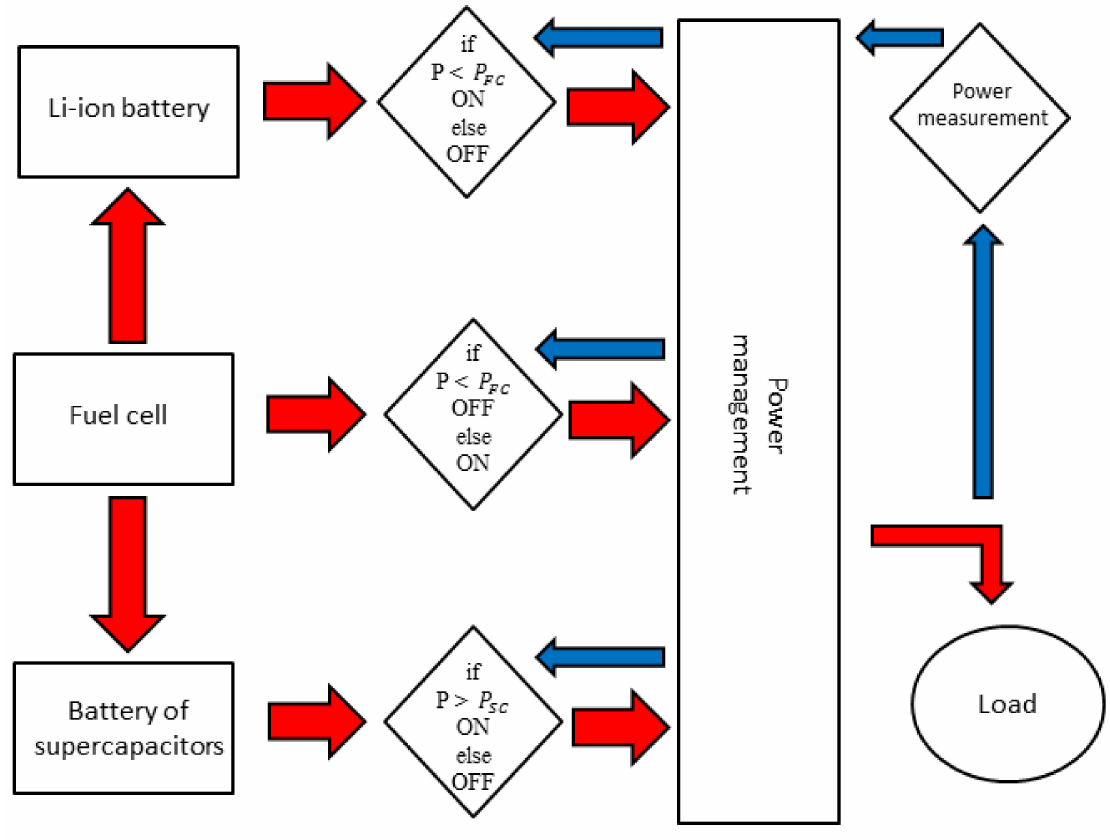
Figure 3. Simplified control algorithm of the hybrid power system. Red arrows indicate the power flow, blue arrows indicate the information signal